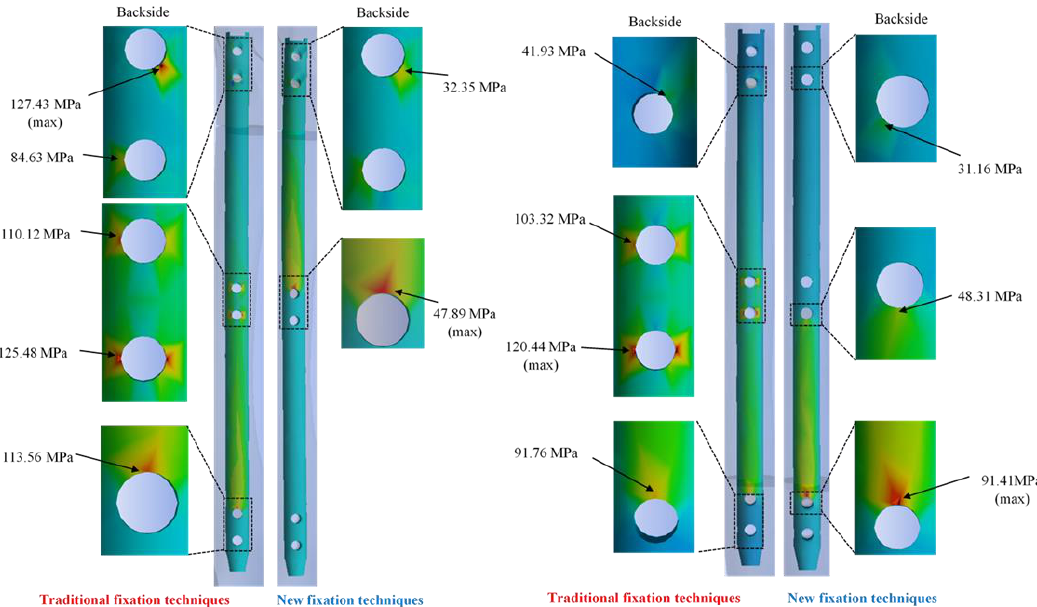
Figure 14. Maximum principal stress distribution on the composite interlocking nails with a length of 120 mm at a 1 mm proximal shaft fracture with the fixation techniques using the traditional P – D fixation technique and the new P – M fixation technique (left), and at a 1 mm distal shaft fracture with the fixation techniques using the traditional P – D fixation technique and the new M – D fixation technique (right).